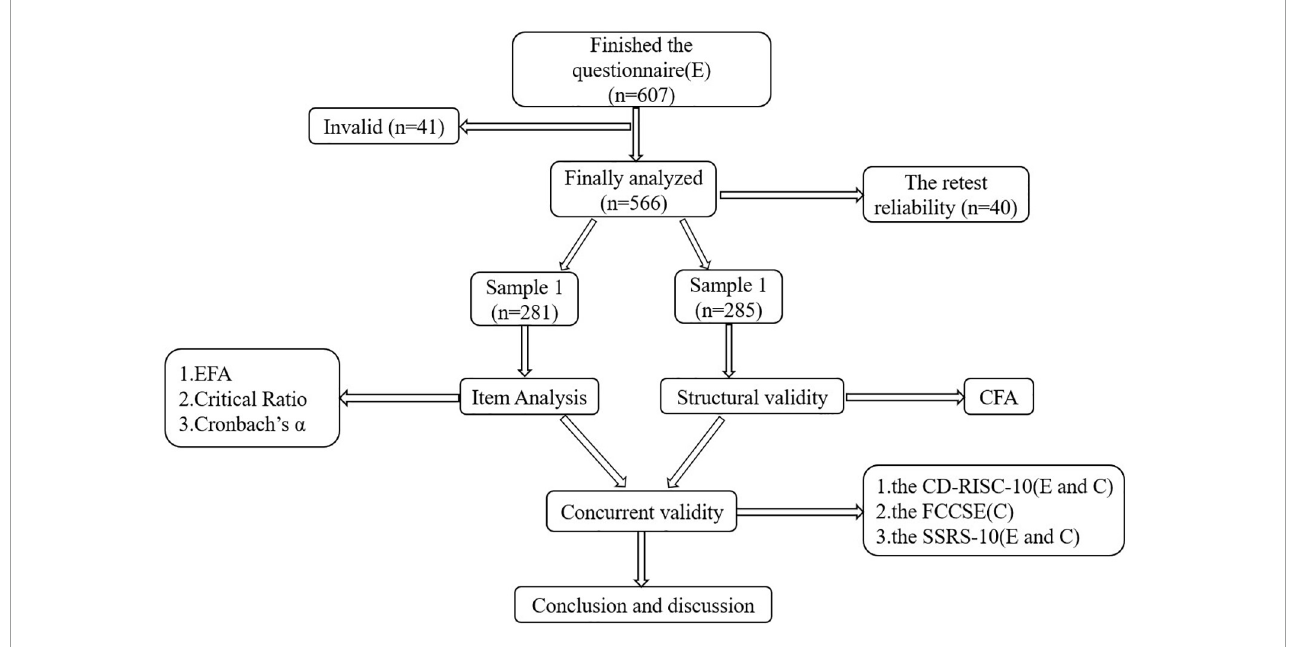
FIGURE1 Validation process among community-dwelling disabled elderly